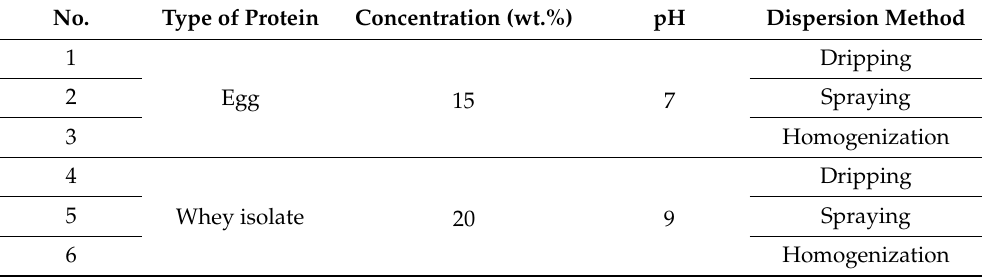
Table 2. Parameters of the process of obtaining protein aerogel particles. No. Type of